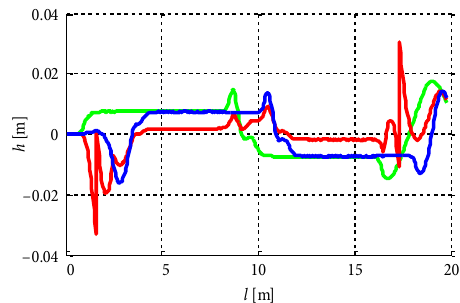
Fig. 9. Distances between center points of geometric blocks of vehicles and lines on which these center points should be located for the radial position of the vehicle (simulation